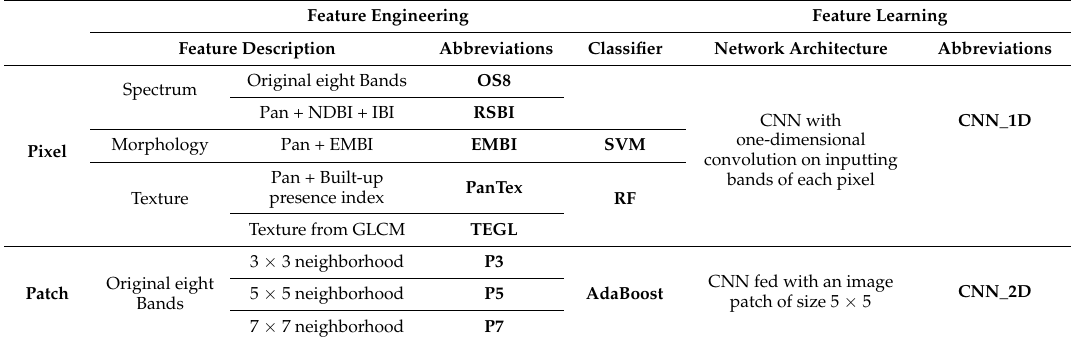
Table 2. Overall framework of method and technology.